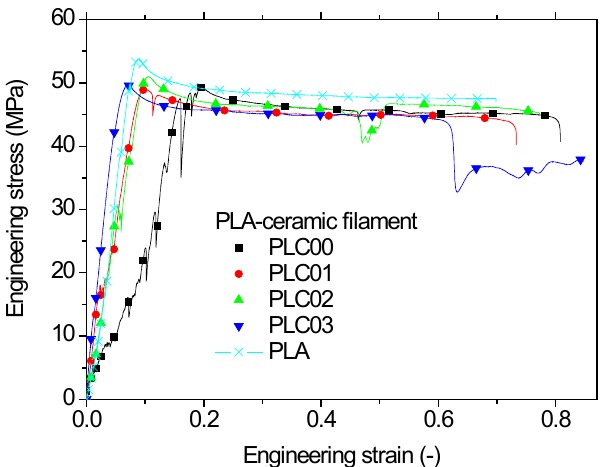
Figure 8. Comparison of the tensile response of PLC and PLA filaments.